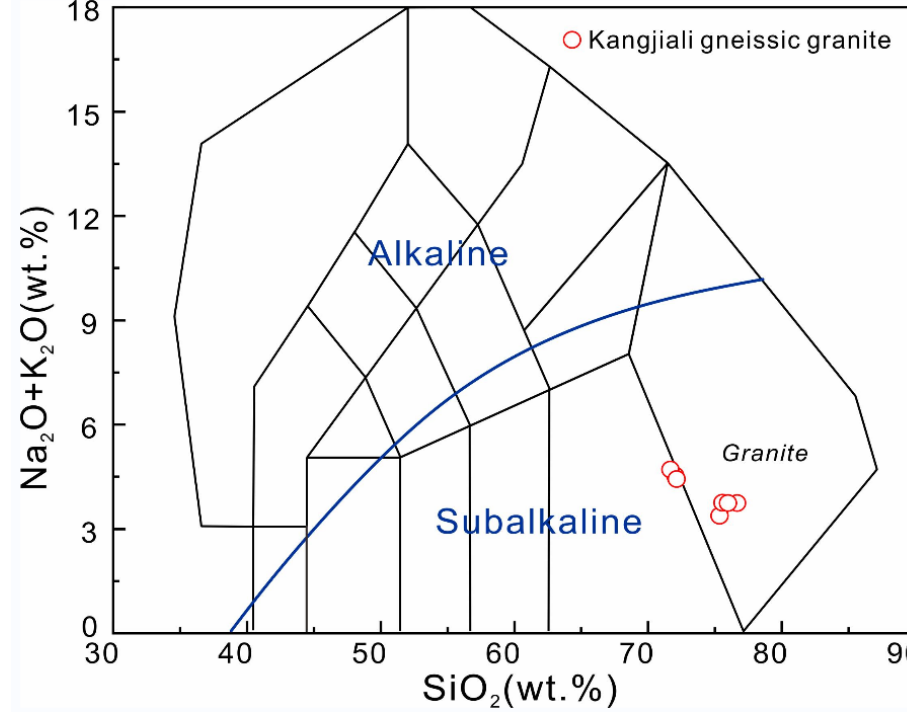
Figure 4. TAS diagram [23] of the Kangjiali gneissic granite.